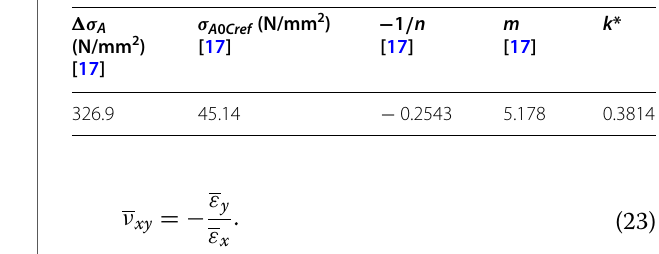
Table 2 Model coefficients for Eq.